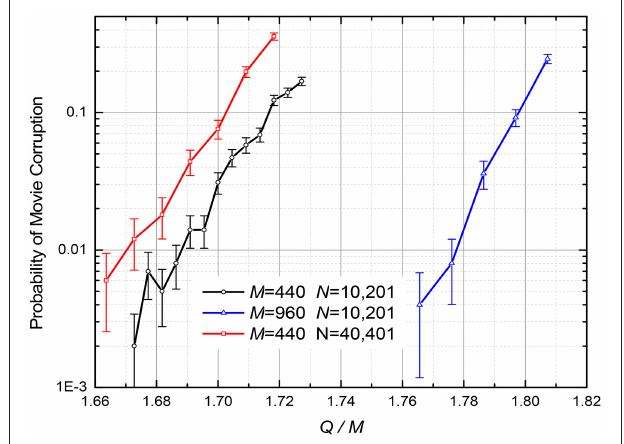
FIGURE 8 | The probability of the retrieved movie’s corruption at the discrete gradient-descent recording described by Equations (5), (7), and (8) (The lines are only guides for the eye). η 0.01; D 1. The recording iterations were = = stopped when the errors ε i ( q + 1) , defined by Equation (7), reached 0 for all i and q . The error bars represent the standard deviation of the mean, based on 1,000 simulations for M 440 and 500 simulations for M 960. = =